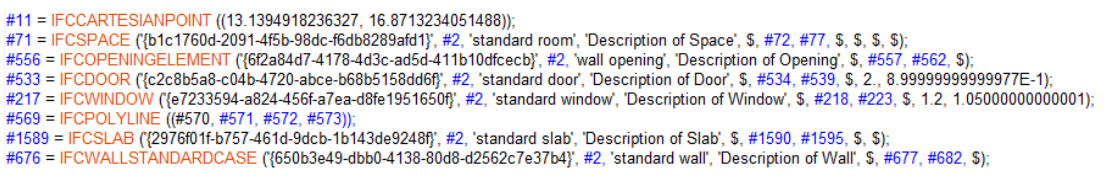
Figure 4. Excerpt of interesting entries of an Industry Foundation Classes (ICF) formatted file (ISO 10303-21).